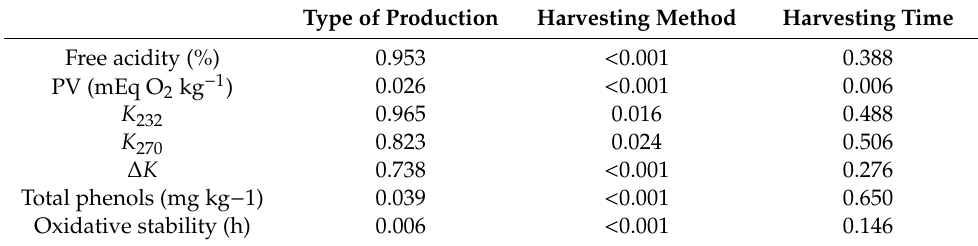
Table 1. p -Values from a three-way ANOVA (type of production, harvesting method and harvesting time) performed on the chemical and physical-chemical data of Verdial de Badajoz olive oil.